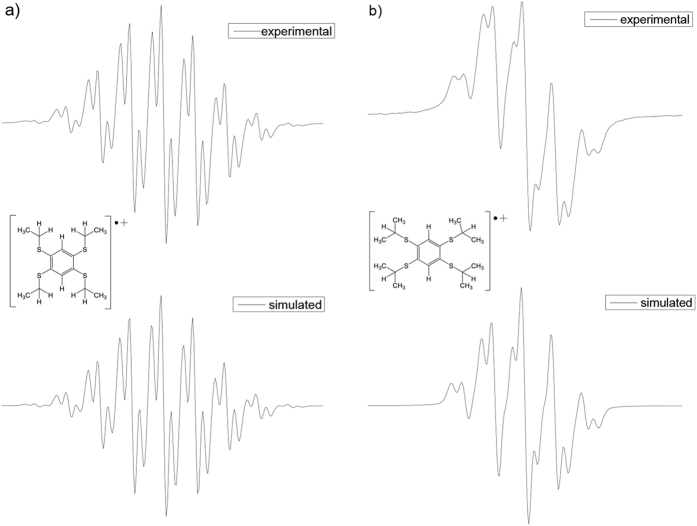
(a) Experimental (CH2Cl2, 1 × 10−4 M, 233 K) and simulated EPR spectra of TEB·+ with  G (8H),  G (2H), g = 2.0076; (b) Experimental (CH2Cl2, 1 × 10−4 M, 233 K) and simulated EPR spectra of TPB·+ with  G (8H),  G (2H), g = 2.0072.